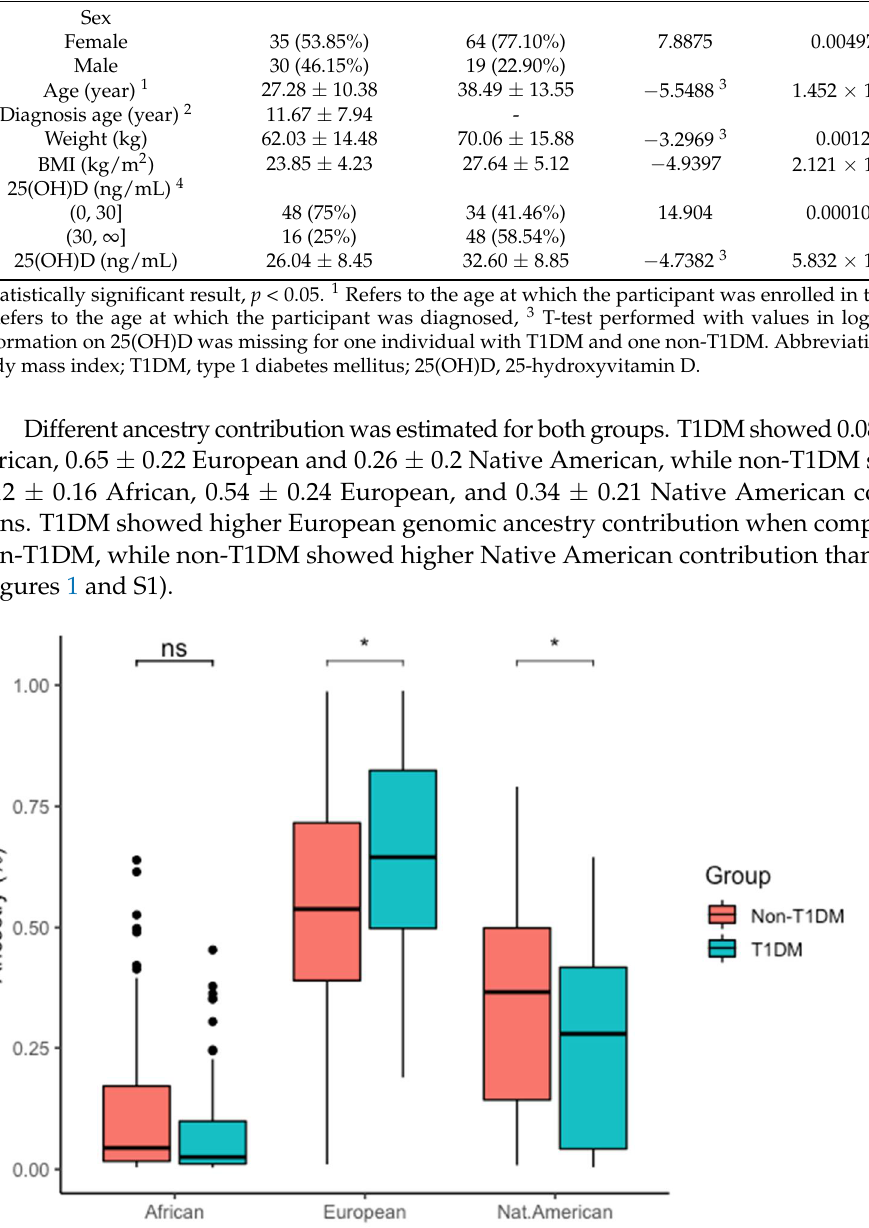
Table 1. Clinical characteristics of T1DM and non-T1DM groups.